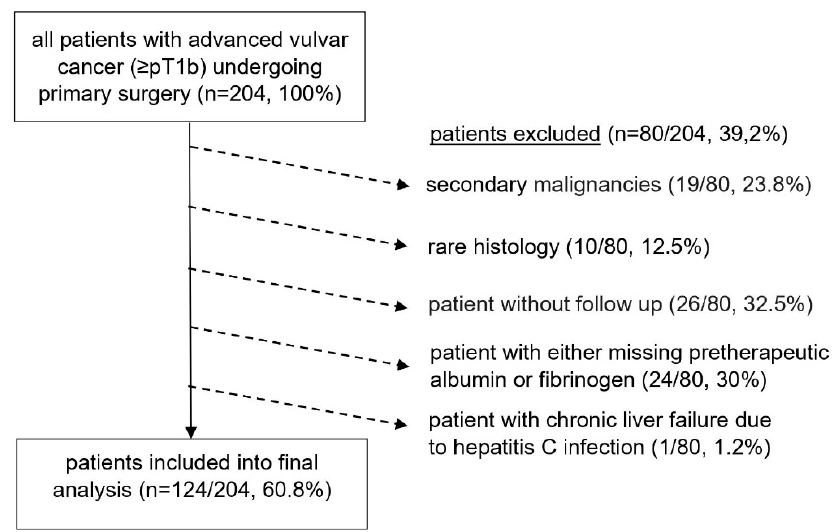
Figure 1. Flowchart depicting the constitution of the patient cohort evaluated at final analysis ( n = 124). Out of 204 patients with advanced vulvar cancer ( ≥ pT1b) who underwent primary surgery initially evaluated, 80 were excluded for not meeting primary inclusion criteria: due to secondary malignancy (19), rare histotype of tumor (10), chronic liver failure due to hepatitis C infection (1), missing follow-up (26) and either missing pretherapeutic albumin or fibrinogen (24).